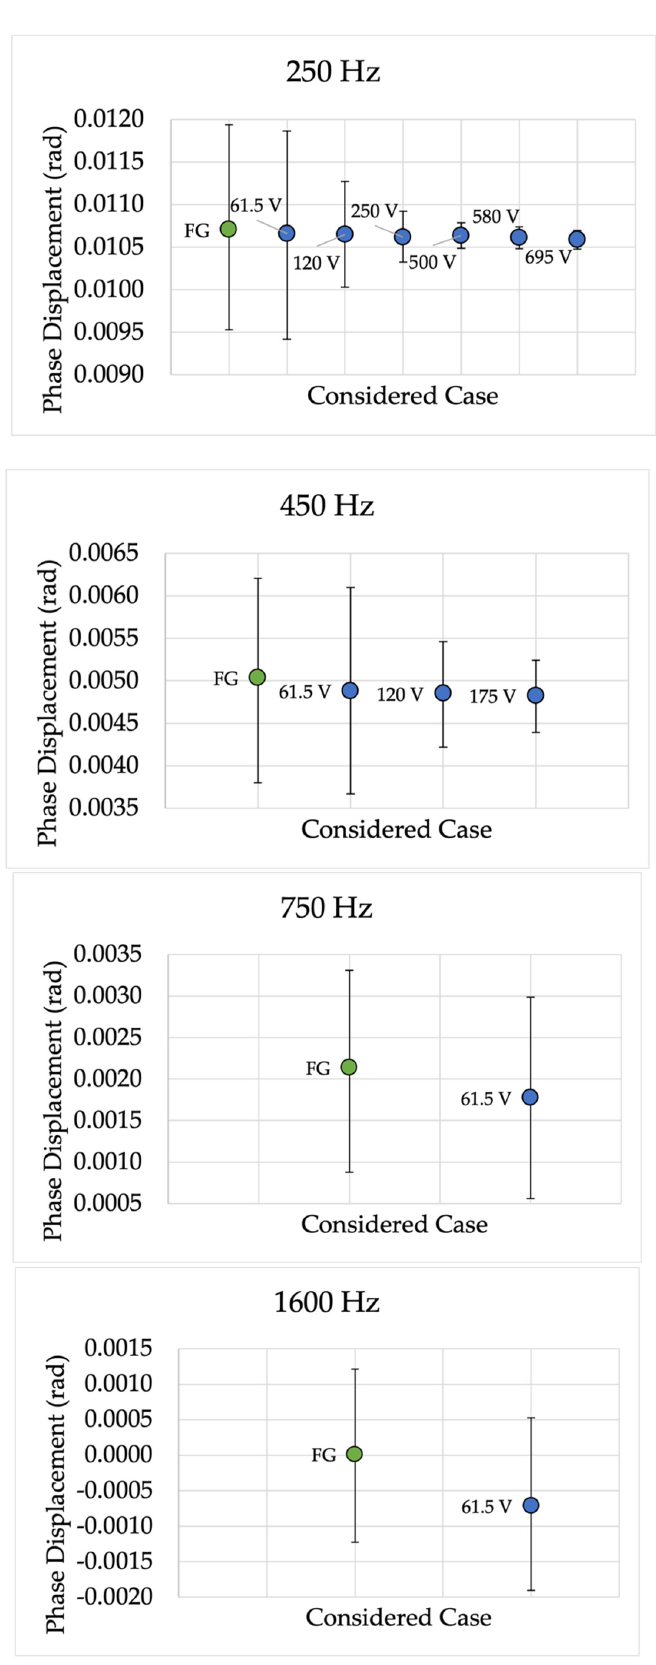
Figure 8. Phase displacement 95% confidence intervals for different frequencies and for device P.